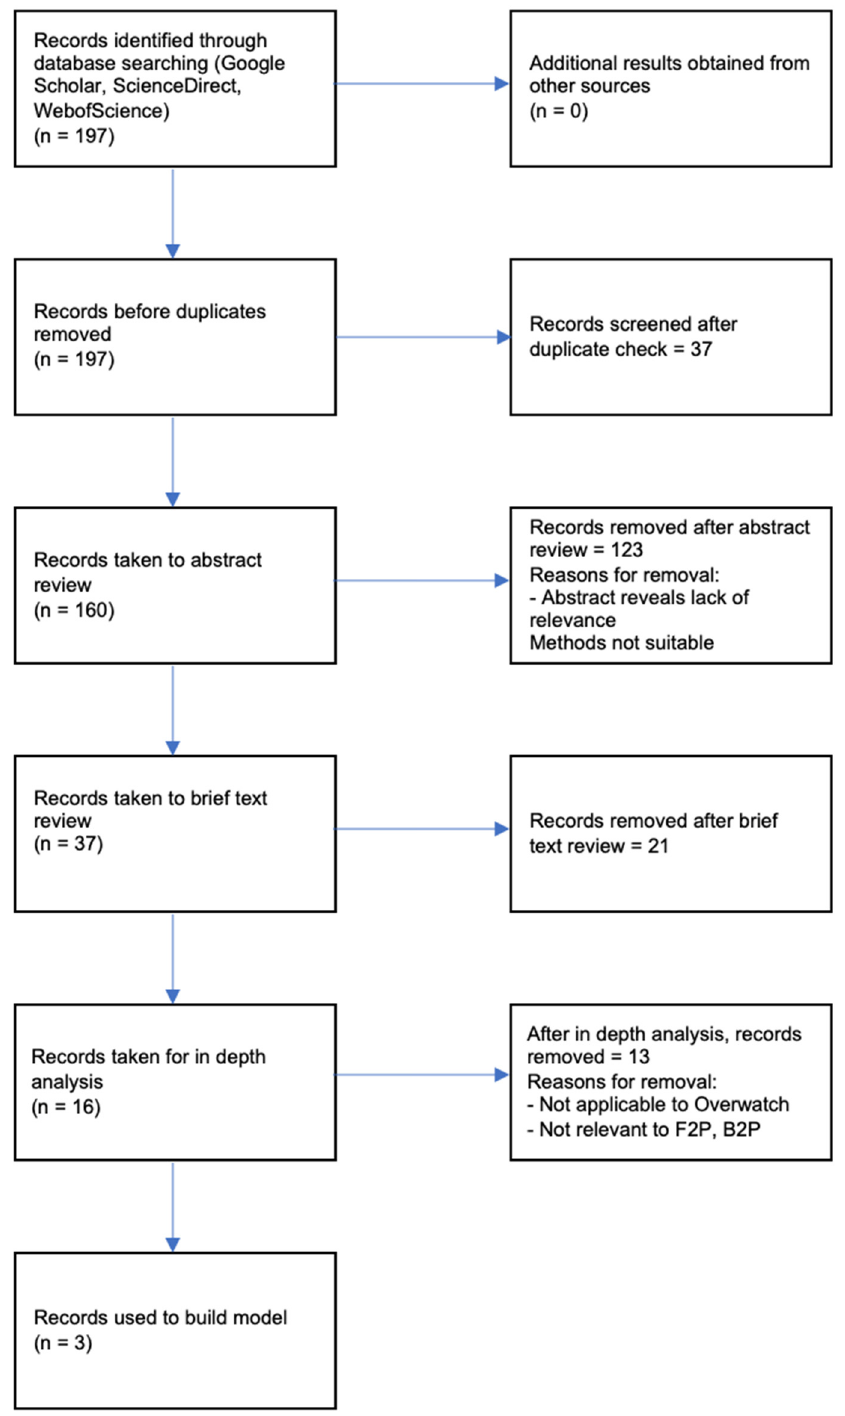
Figure 1. Process used, and associated number of records for each stage.